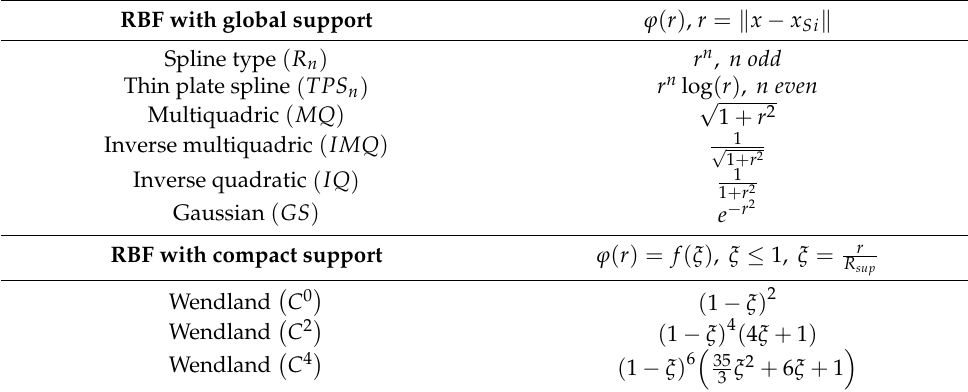
Table 1. Radial basis functions with global and compact support. RBF with global